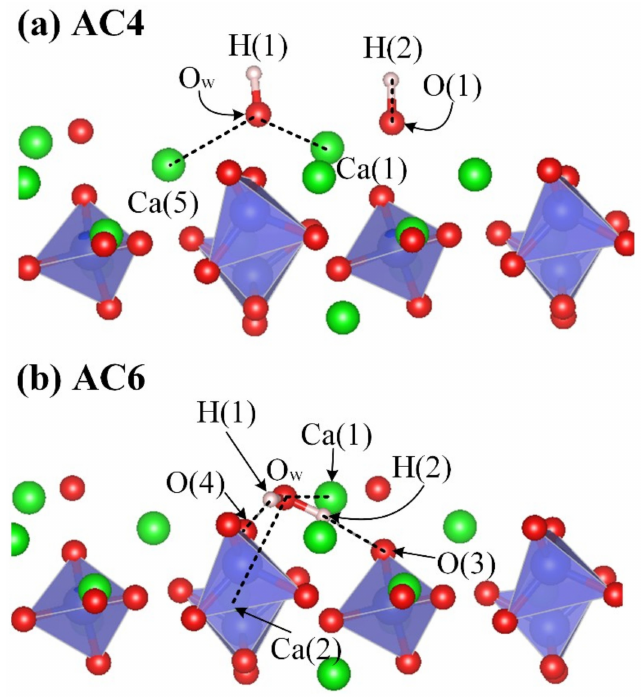
Figure 6. Atomic labelling for ( a ) AC4 and ( b )